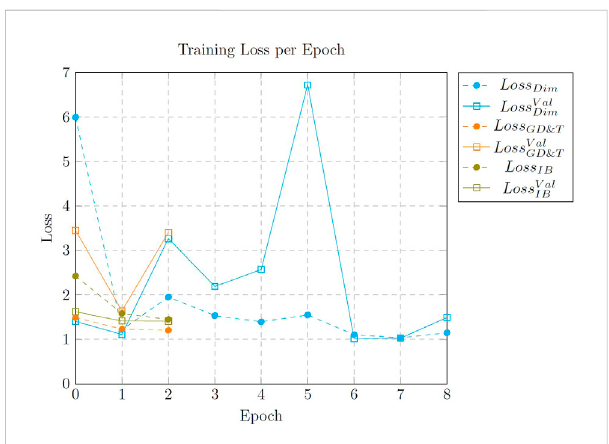
FIGURE 11 Loss per epoch when training the different recognizer. Loss and validation loss are displayed with dashed lines and solid lines,